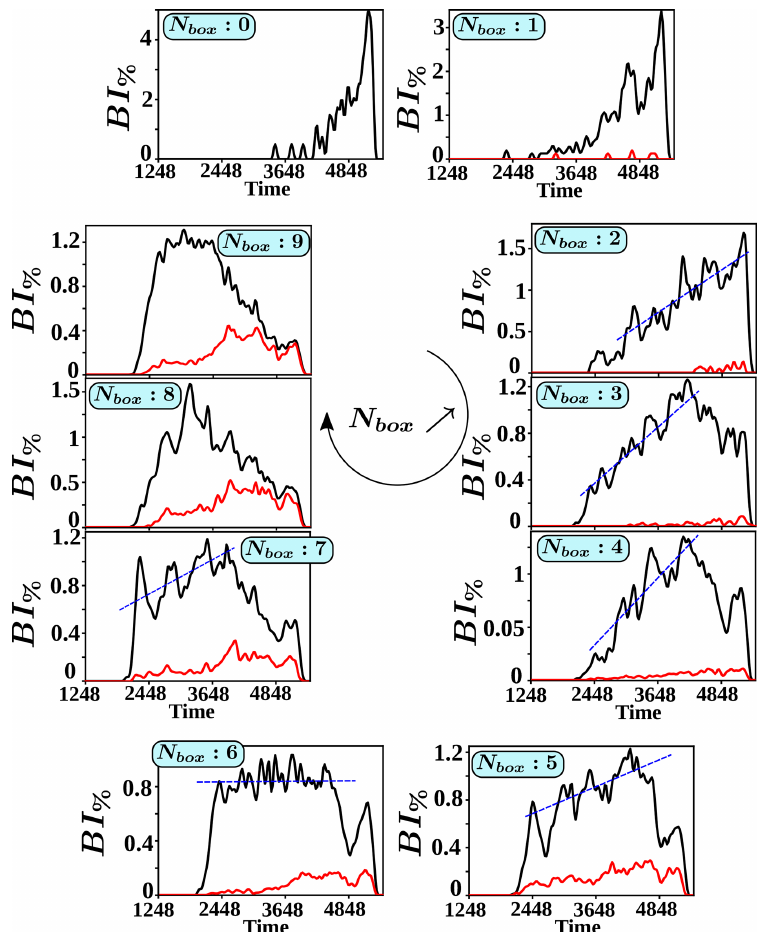
Figure 8. FCE configuration: time history of the reflected ion percentage BI % ; each value is computed during a short integrated time interval (cid:49) (cid:101) T = (cid:101) τ ci / 20 for the different boxes. Within this interval, only the newly reflected ions are memorized. As for Fig. 6, black and red lines correspond to the case where the electric field is included ( (cid:101) E l (cid:54)= 0) or excluded ( (cid:101) E l = 0), respectively. We have used the same normalization in order to compare both cases. The blue dotted straight lines are not obtained from a data linear approximation but only indicate the mean values of the time